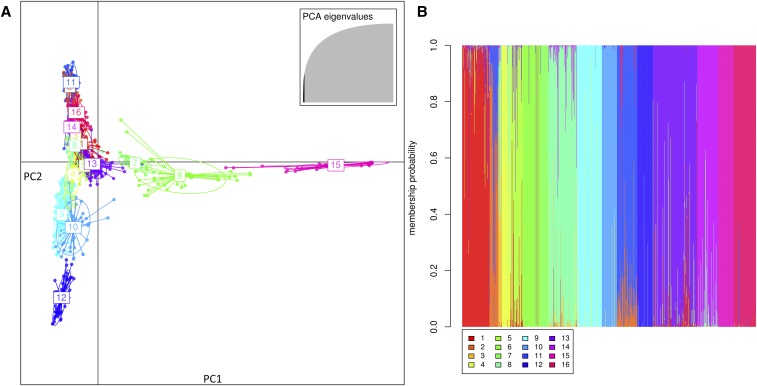
Genetic structure of the collection of 917 accessions of pea. (A) Scatterplot showing the first two principal components of the DAPC. Wild peas are grouped in clusters 6 and 15, winter sown peas are found in clusters 4, 9, 10, and 12, and the remaining clusters are spring sown peas. Note the position of the peculiar cluster 7, containing very original east Asian peas cultivated in tropical regions. The first axis nicely segregate wild vs. cultivated material, while the second axis spring and winter peas. (B) Membership probability plot of individuals.